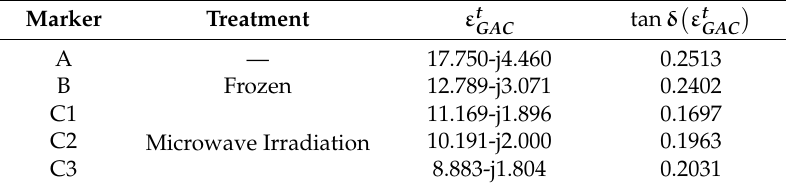
Table 2. The complex permittivity of the ideal perfect granular activated carbon (GAC) in Model A.